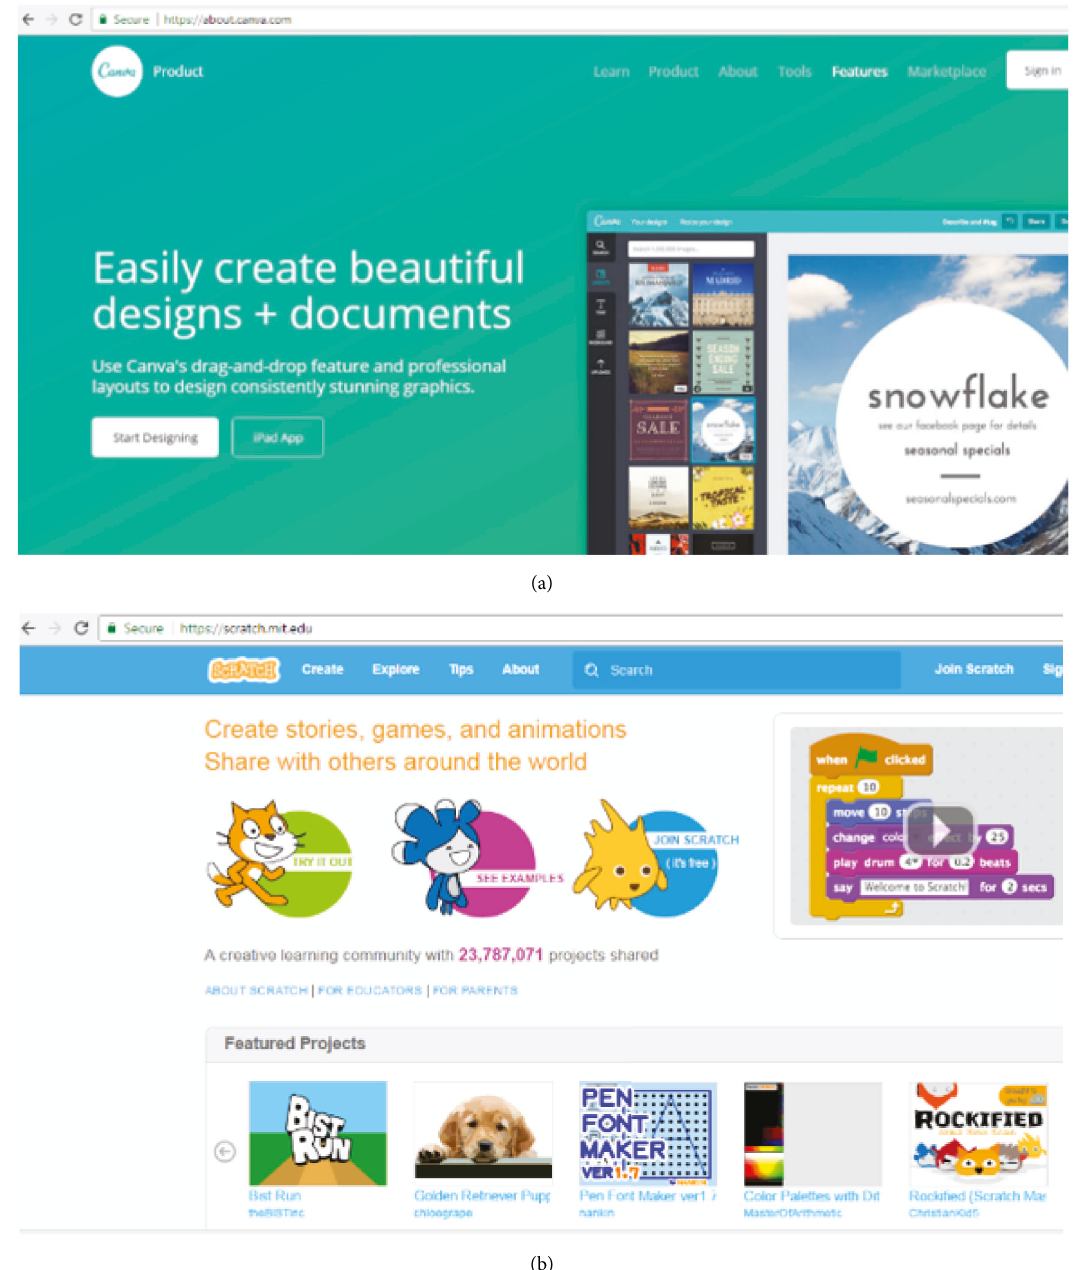
Figure 16: Tools used for digital design: Canva (a) and Scratch